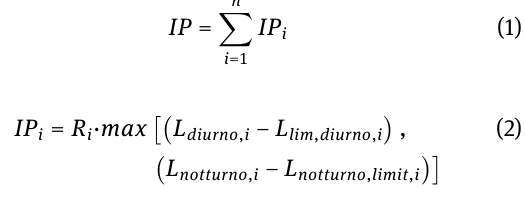
Figure 7: Definition of a critical area. The contours of two critical areas are coloured in blue and magenta, while buildings are in